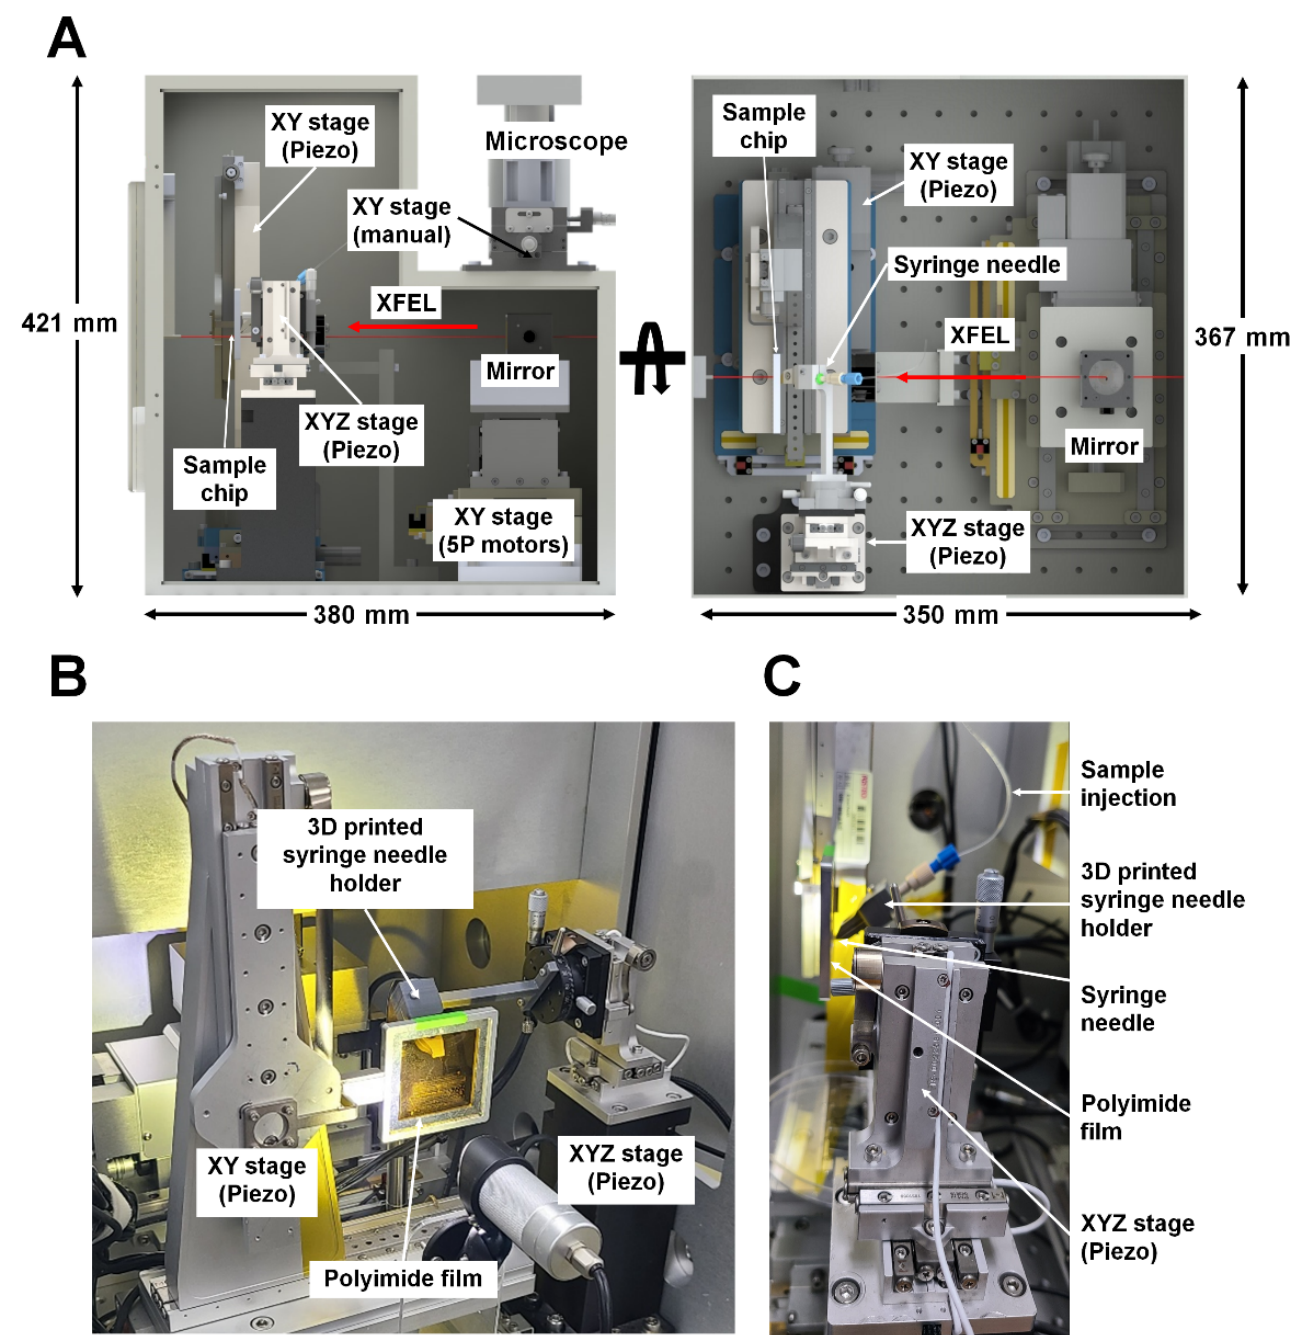
Figure 1. BITS system for SFX experimentation. ( A ) Schematic of the BITS system containing the translation stages for sample injections and target scanning. ( B ) Photo of current BITS system in the FT-SFX chamber. ( C ) Close-up view of XYZ -axis motorized piezo stage for alignment between syringe needle and polyimide film.